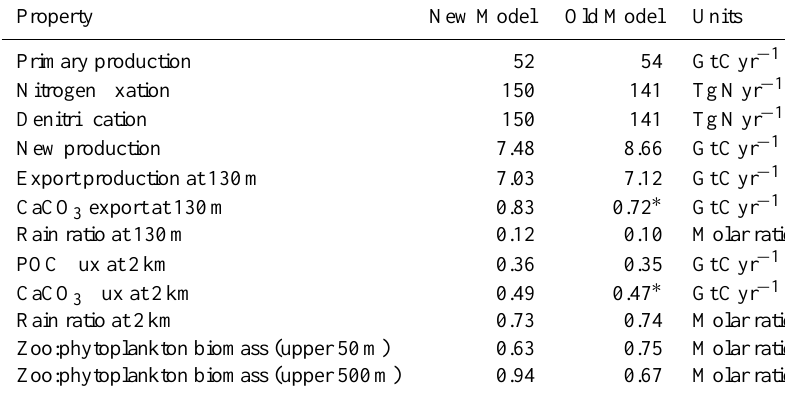
Table 3. Comparison of globally important properties between model